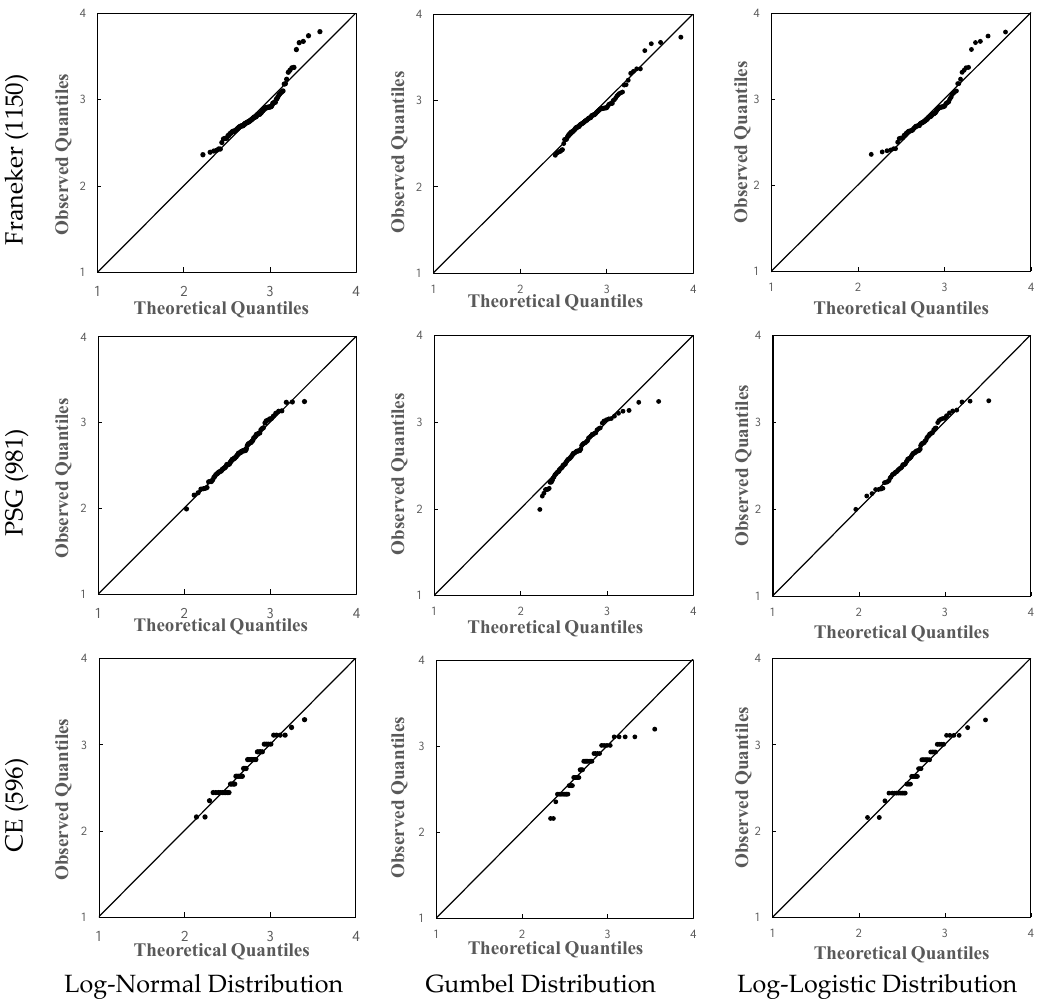
Figure 1. Q ‐ Q plots of the peak demand coefficient for: ∆ t = 1 min; three distributions ( LN , Gu and LL ); and different users ( N us = 1150, 981 and 596).